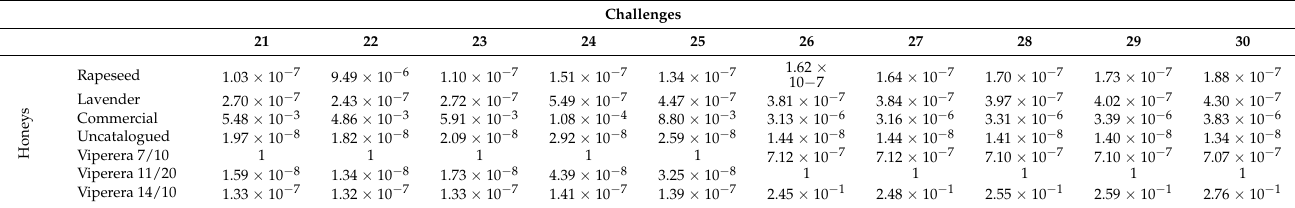
Table 8. Results of the neural network against 35 challenges (from 21 to 30).